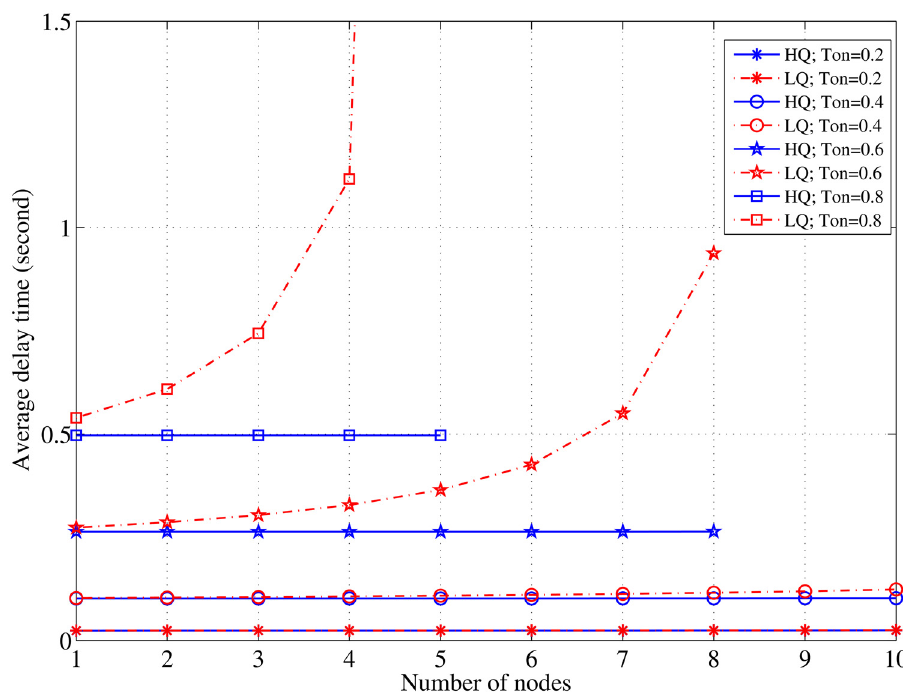
Fig 6. Relationship between N and the delay in case of various values of τ off ; λ LQ = λ HQ = 3 [pkt/s].